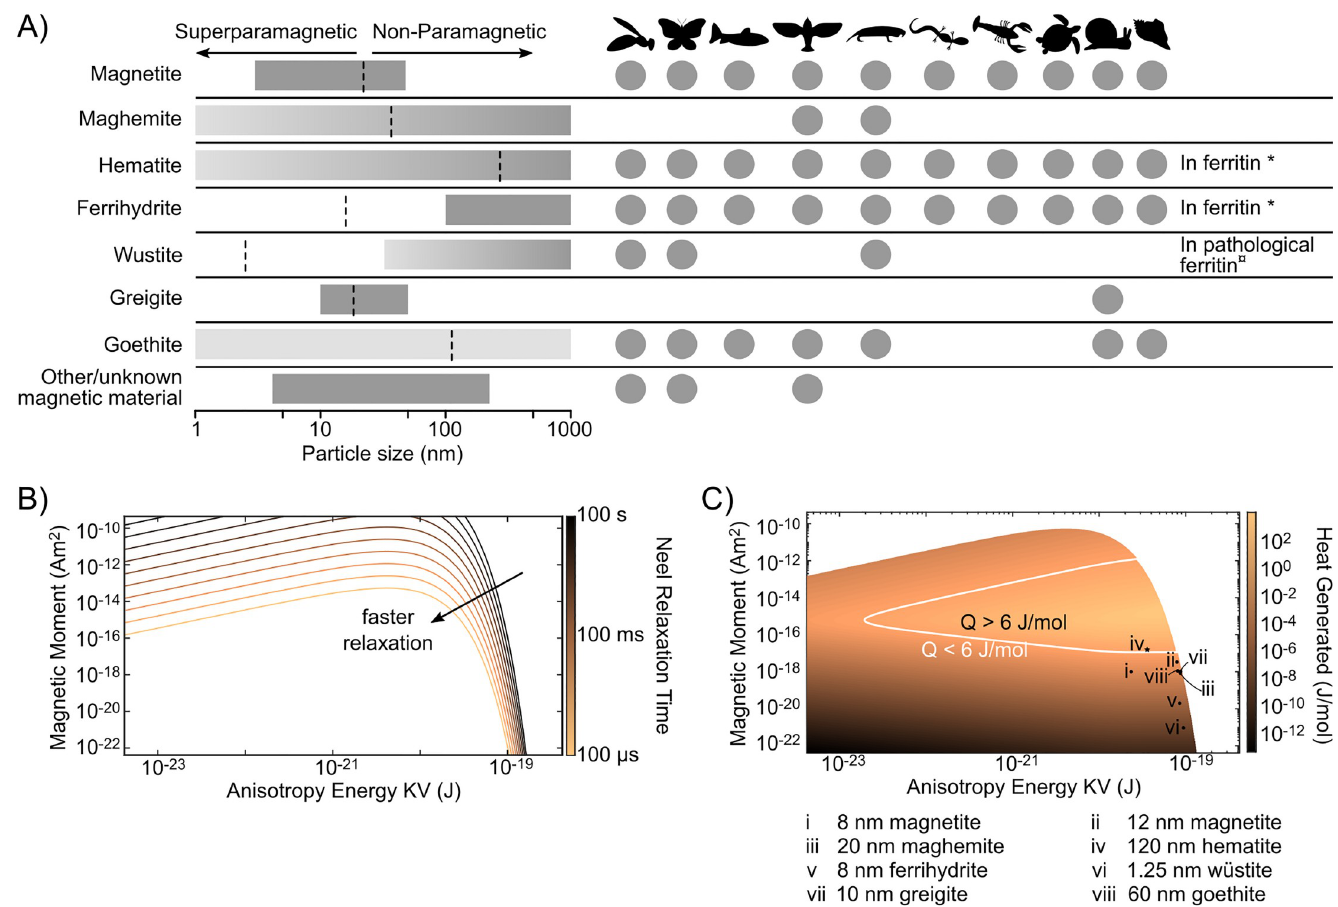
Fig 3. Experimentally observed biogenic magnetic particles include good candidates for magnetocaloric heat changes. (A) Rows show materials found to be present in biogenic nanoparticles. Grey bars indicate sizes found in literature [10, 12, 15, 39–41], with lighter gray representing uncertainty about limits (for example, goethite particles are found in Columba livia pigeons, but the particle size is unconfirmed). Black dashed lines represent the boundary (critical diameter) between the superparamagnetic and non-superparamagnetic domains for spherical particles at 300K according to Ne´el relaxation theory. Grey circles indicate that nanoparticles of the materials indicated on the left have been identified in one or more members of the order indicated. Animal orders shown are: Hymenoptera, Lepidoptera, Salmoniformes, Columbiformes and Passeriformes, Rodentia, Caudata, Decapoda, Testudines, Panpulmonata, and Patellogastropoda. (B) The Ne´el relaxation rate of a particle can be predicted via Ne´el relaxation theory using the magnetic moment and anisotropy constant of the particle. Contour lines show consistent Ne´el relaxation times as a function of magnetic moment and anisotropy energies. Contours range from 100 microseconds to 100 seconds. Assuming the Ne´el relaxation must be faster than the time of animal reorientation constrains the parameter space of allowed superparamagnetic nanoparticles. For particles with magnetic moments < 0.1 fAm 2 a 1,000,000x increase in the choice of relaxation time threshold results in an increase in maximum particle anisotropy of < 10x. (C) Maximum heat generated under rotation as a function of magnetic moment and particle anisotropy energy, for particles with relaxation values below 100 milliseconds. The white line shows the threshold for particles that are expected to produce at least as much heat under rotation ( � 6 J/mol) as is expected from the synthetic magnetosensor Magneto 2.0 under application of a 275 mT field. Black icons represent particles of materials whose presence has been established in animals with magnetic senses. Of these, hematite (black star) has been found in sizes capable of generating greater than 6 J/mol. Black circles show other magnetic materials found in animals with magnetosensory abilities, but whose material properties and size distributions are less suited for use in RME-receptors. Materials: i) 8 nm radius magnetite, ii) 12 nm magnetite, iii) 20 nm maghemite, iv) 120 nm hematite, v) 8 nm ferrihydrite, vi) 1.25 nm wu¨stite, vii) 10 nm greigite, viii) 60 nm goethite. Heat generation values assume 25 μ T field, near the lower limit for the range of observed GMF field strengths and use published values of material saturation magnetization strengths and anisotropy constants, and a rotation from aligned with the hard axis to aligned with the easy axis [47–59]. � [39, 60–62] ¤[39].